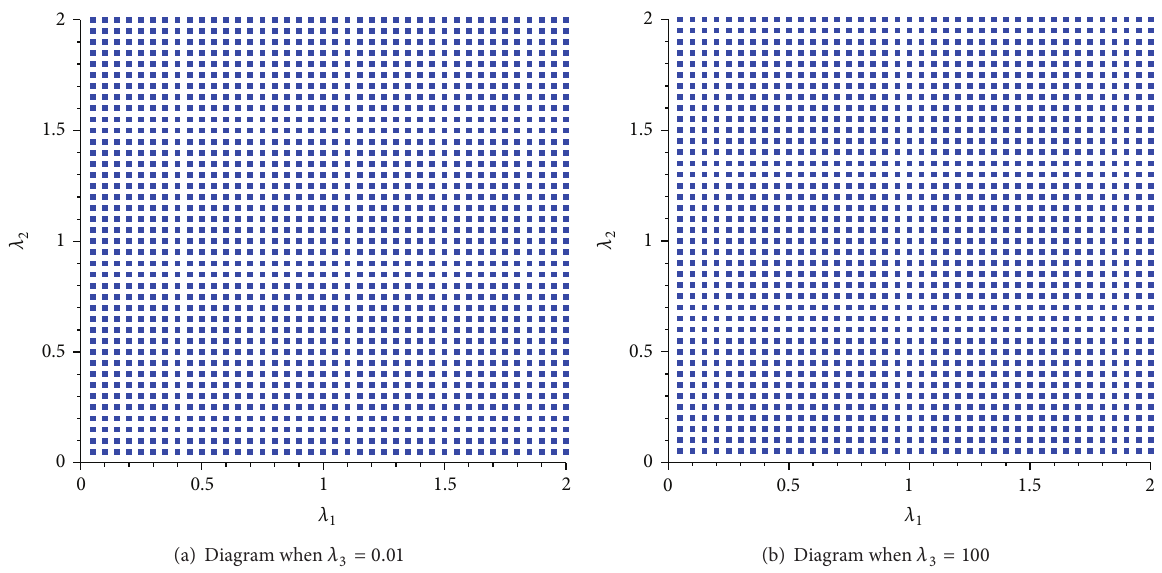
Figure 2: Limit behavior of the dynamical system (31) 0 < 𝜆 1 , 𝜆 2 ≤ 2 and some fixed values 𝜆 3